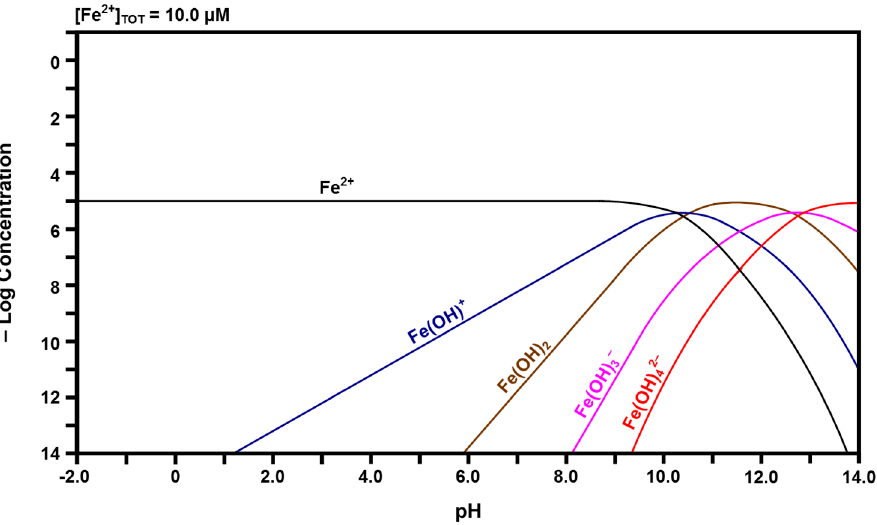
Figure 7. Calculated speciation diagram of Fe 2+ ‐ H 2 O.